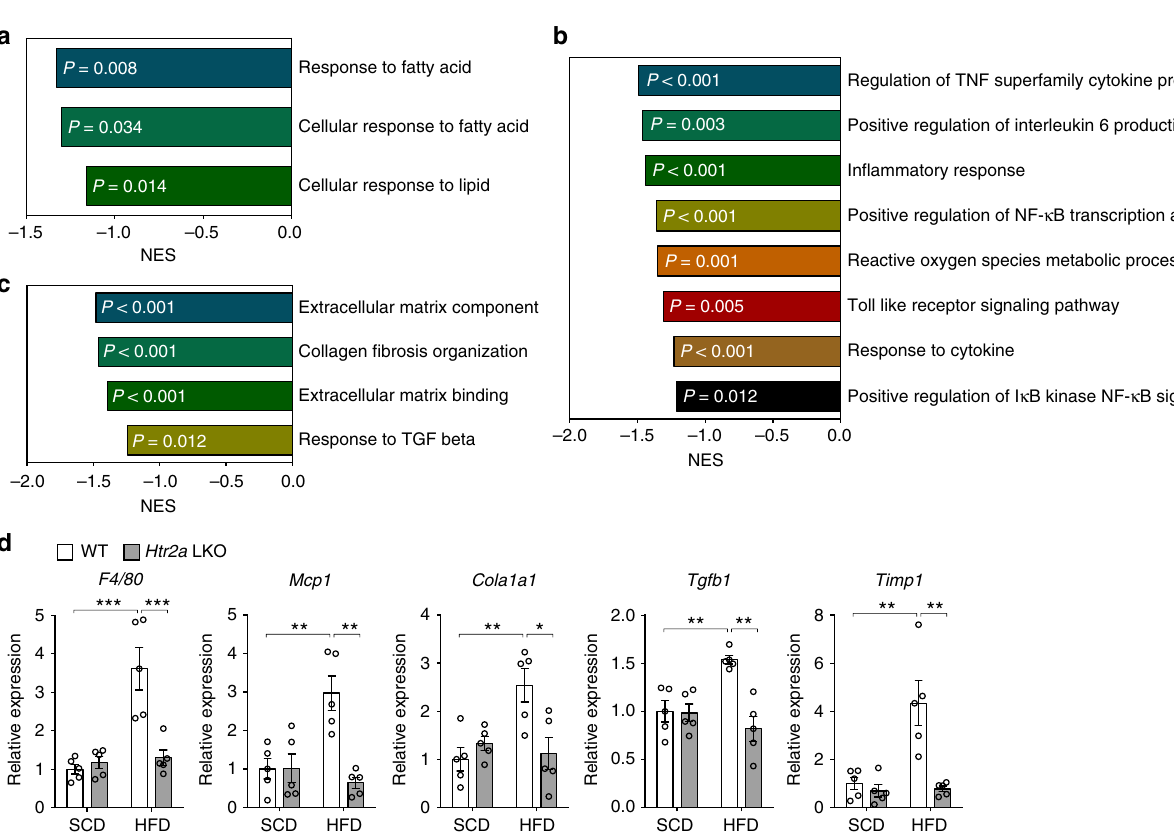
Fig. 5 HTR2A mediates the in fl ammatory and fi brogenic action of GDS in the liver. a – d The 12-week-old WT and Htr2a LKO mice were fed HFD for 8 weeks. a – c GO gene sets were analyzed by GSEA for HFD-fed Htr2a LKO mice livers compared with WT littermates livers. Gene sets related to hepatic steatosis ( a ), in fl ammation ( b ), and fi brosis ( c ); n = 3 per group. d Relative mRNA expression of genes involved in in fl ammation and fi brosis as assessed by qRT-PCR